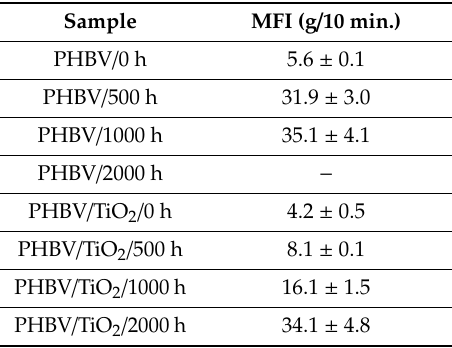
Table 4. Changes in the MFI of the PHBV and the PHBV / TiO 2 samples as a function of accelerated weathering time.